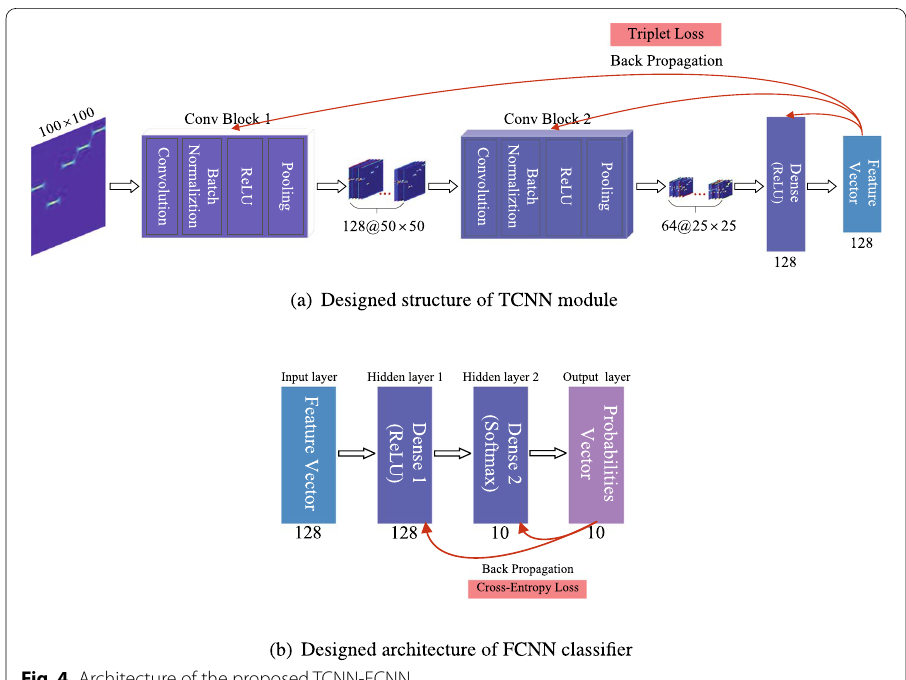
Fig. 4 Architecture of the proposed